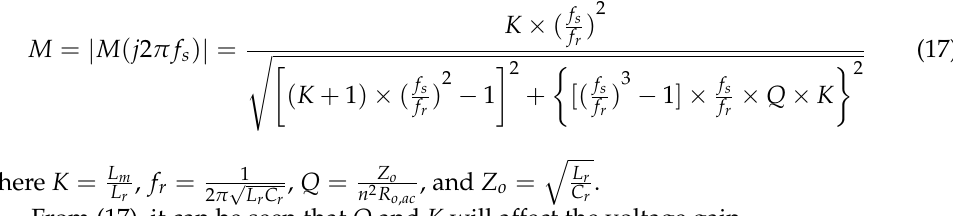
Figure 7. Two-port model of the FHA resonant circuit.